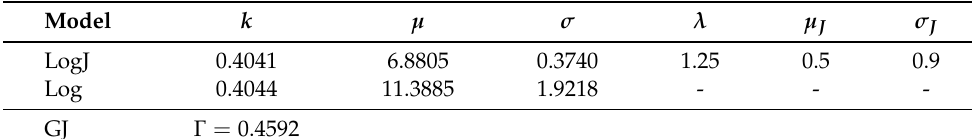
Table 1. Parameter values for models LogJ, Log, and GJ. Model k